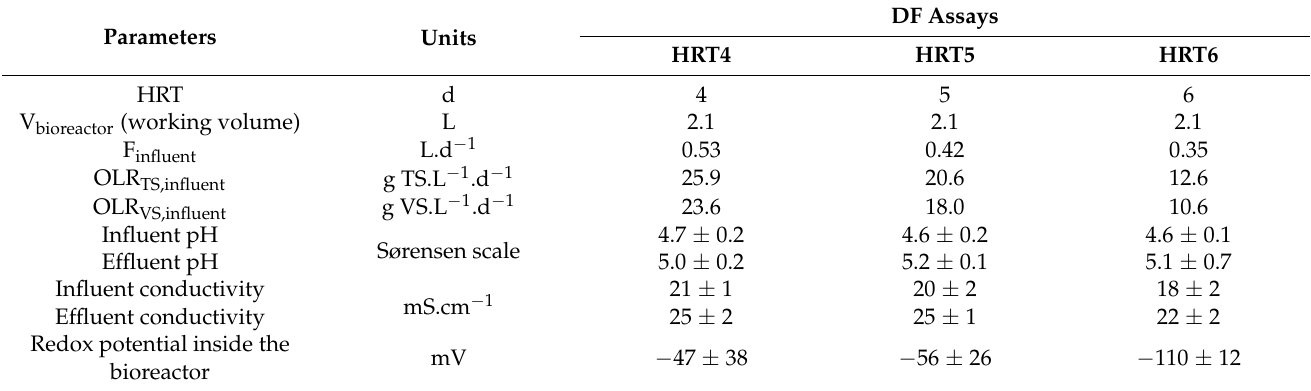
Table 3. Average values ( n = 10 samples) of pH, redox potential, and conductivity in DF